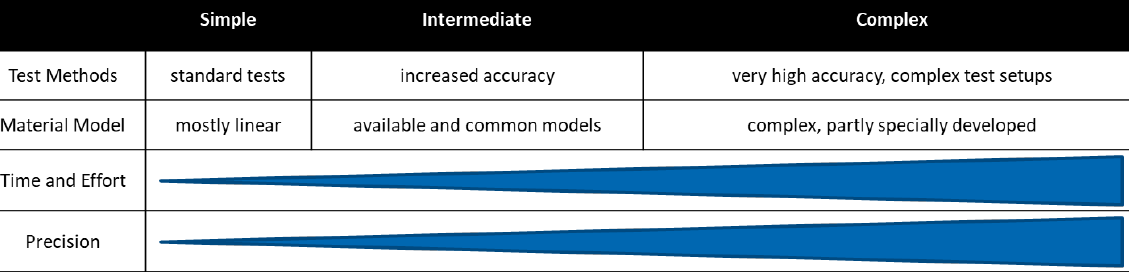
Fig. 1 Correlation between accuracy and effort of calculations.